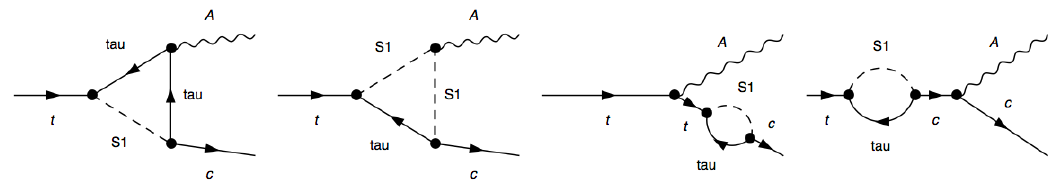
c(cid:13) considered in this work, induced by SU(2) singlet !